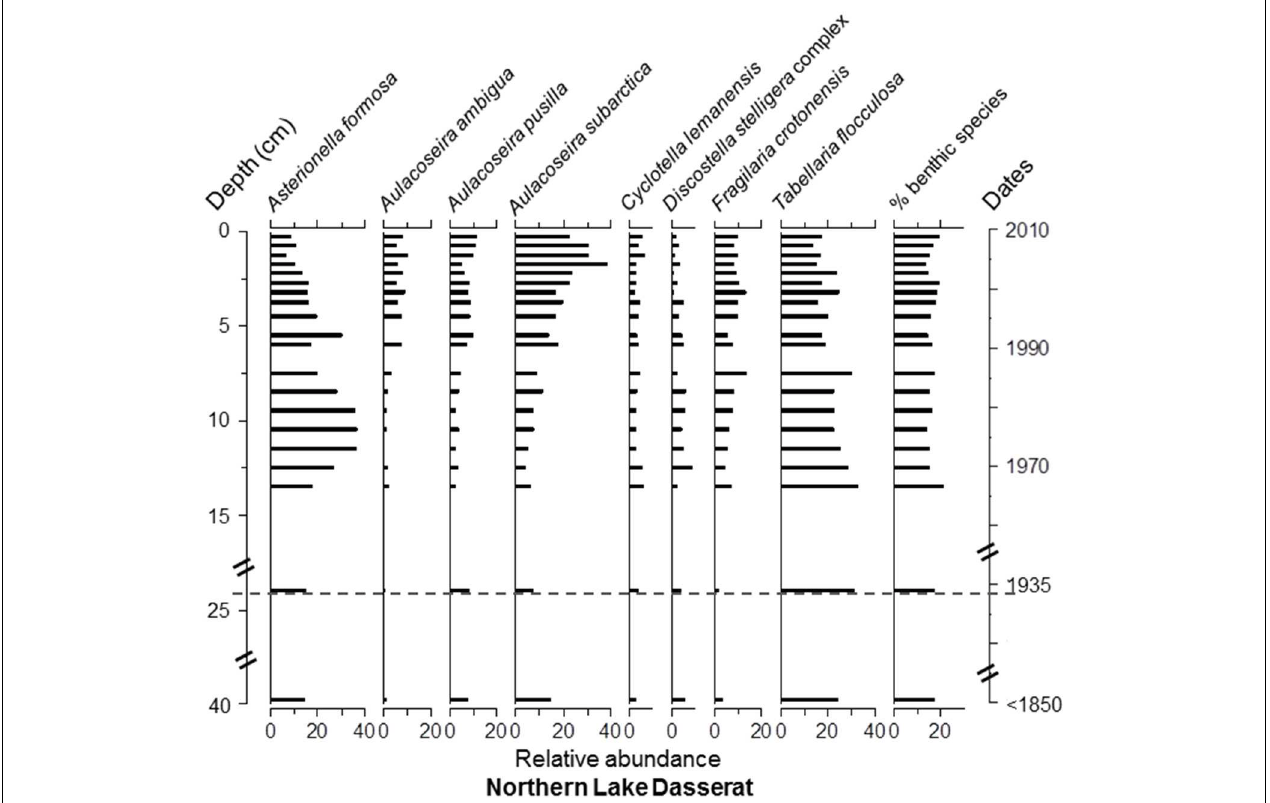
FIGURE 8 | Diatom taxa paleolimnological profiles represented as % abundance in the benthic sediments of Northern Lake Dasserat. The dotted line corresponds to the pre-mining period based on sedimentation rates determined with 210 Pb data.